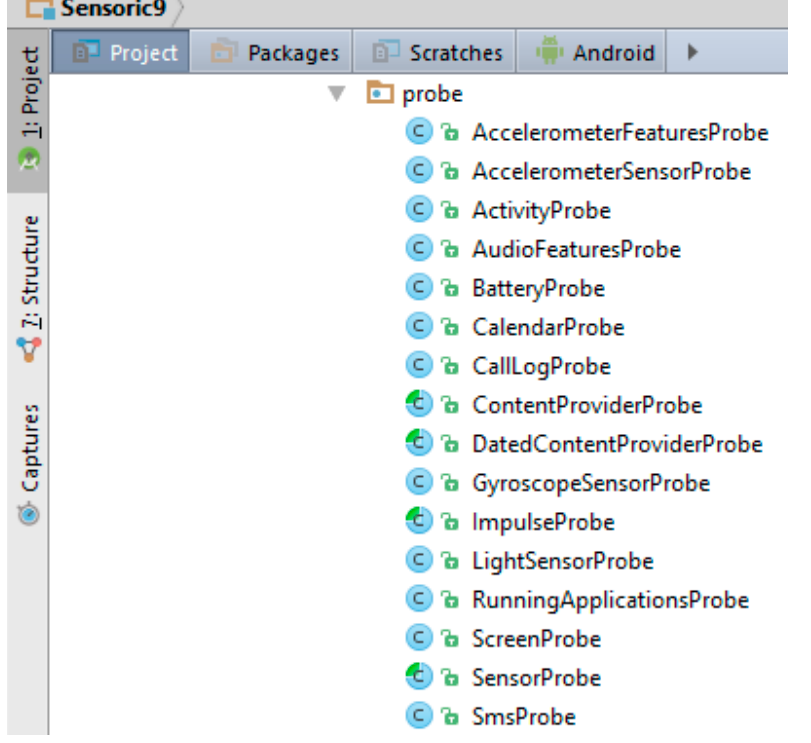
Figure 1. Smartphone sensor data, which were collected via Android application.